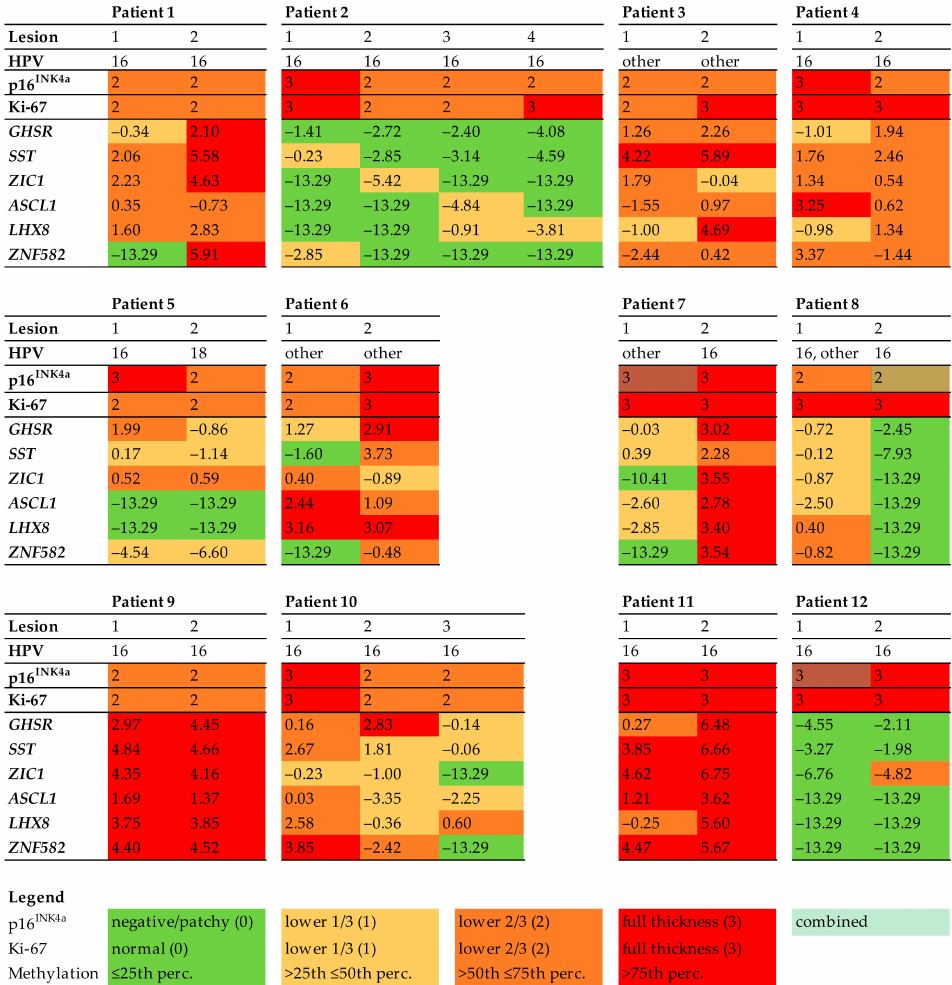
Figure 1. Histopathology and biomarker profiles in 12 patients with multifocal HSIL. Immunohistochemical scores for p16 INK4a (0–3) and Ki-67 (0–3), high-risk HPV genotypes, and log 2 transformed methylation levels of all HSILs. DNA methylation levels for all genes ( GHSR, SST, ZIC1, ASCL1, LHX8, and ZNF582 ) were categorized into quartiles. Each column represents one HSIL. The colours refer to the biomarker expression, as indicated in the legend. Abbreviations: HPV = human